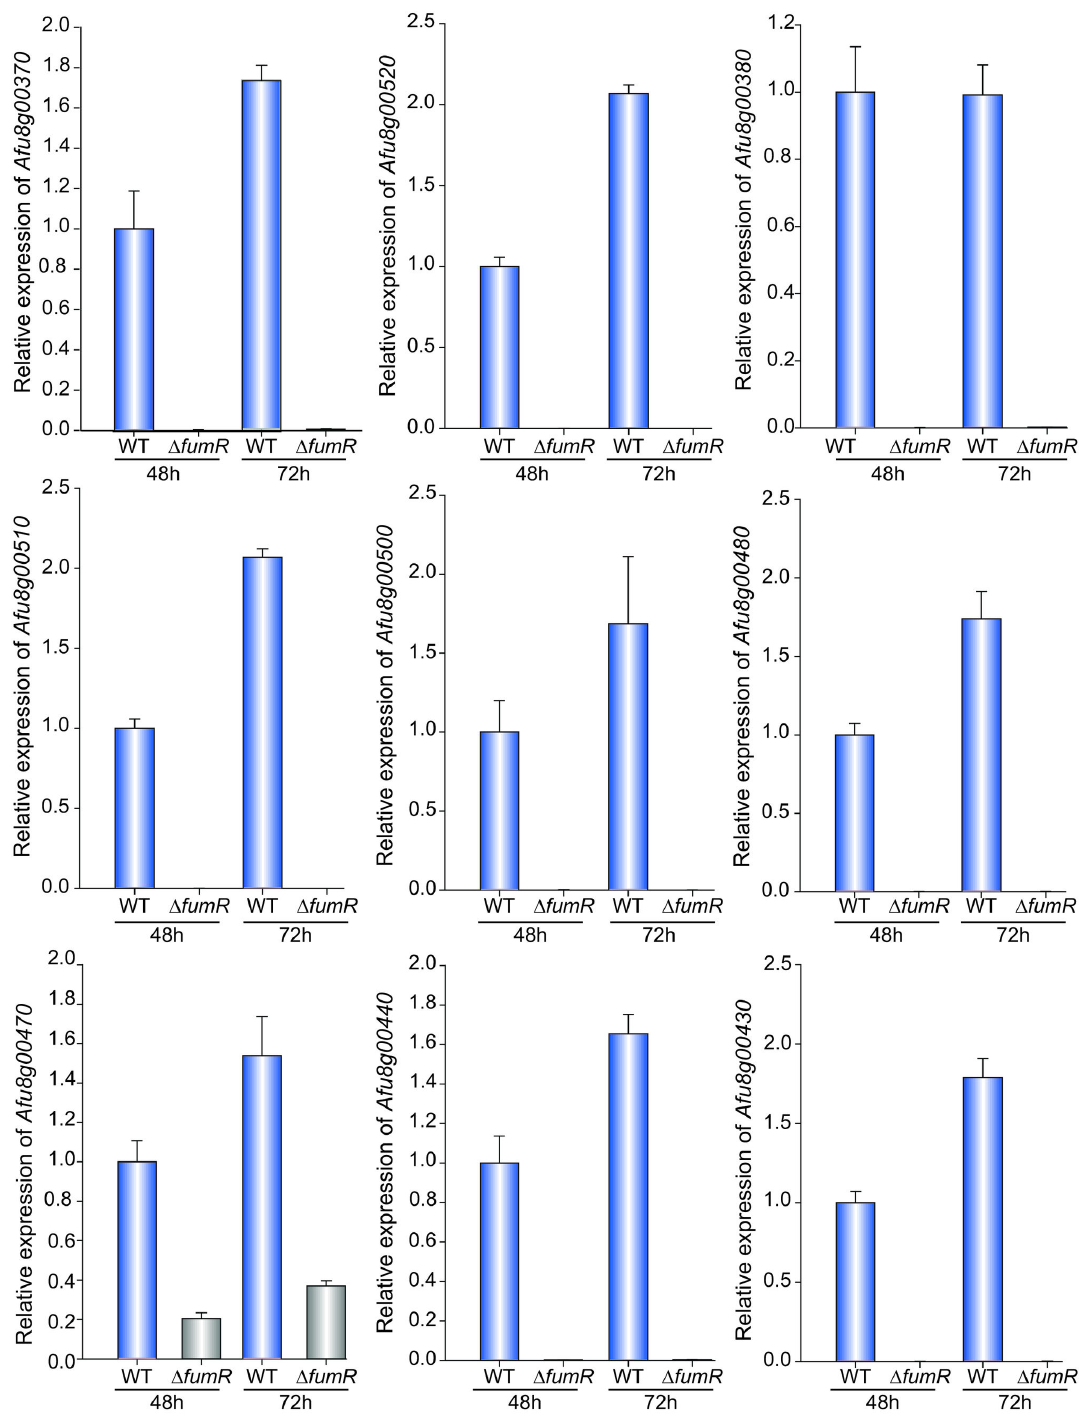
Figure 5. fumR is necessary for the expression of the genes in the fumagillin cluster. The transcriptional pattern of the genes in the fumagillin cluster (Afu8g00370, Afu8g00520, Afu8g00370, Afu8g00510, Afu8g00500, Afu8g00480, Afu8g00470, Afu8g00440, Afu8g00430) was evaluated by qRT-PCR in the wild type (WT, TSD51.1) and α fumR strains. Total RNA was extracted from Czapek-Dox stationary liquid cultures incubated for 48 h and 72 h. The relative expression was calculated using 2 -ΔΔCT as described by Schmittgen and Livak [89]. 18S gene expression was used as internal reference. Means of three replicates is shown. Values were normalized to WT expression at 48 h considered as 1. Error bar represents standard error. doi: 10.1371/journal.pone.0077147.g005 PLOS ONE |